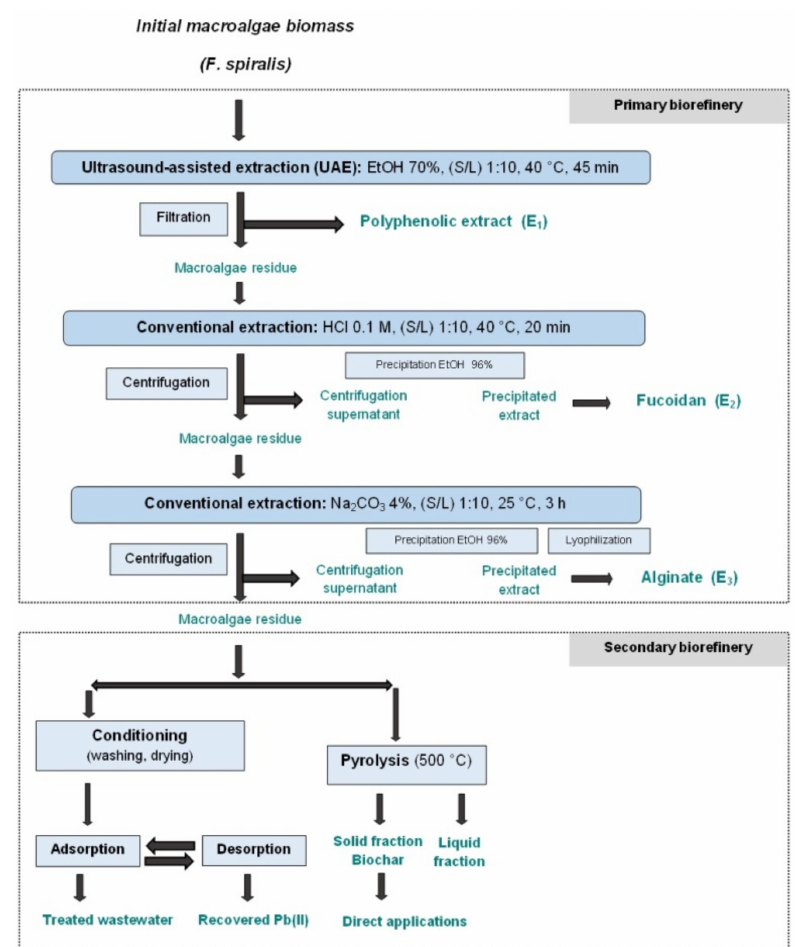
Figure 1. The biorefinery flow sheet designed for Fucus spiralis